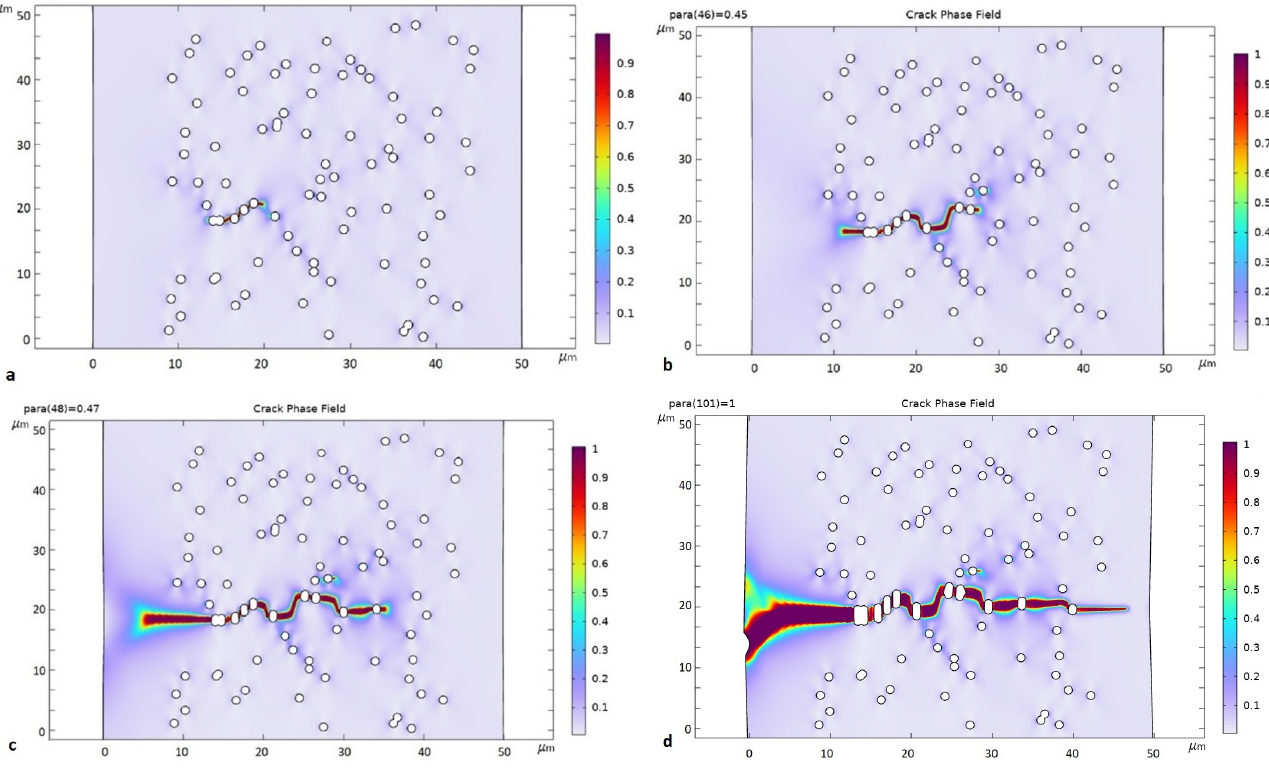
Figure 10. Development of crack under one-axis elongation, where the direction of deformation is vertical: ( a ) ε = 1.7%; ( b ) ε = 1.8%; ( c ) ε = 1.9%; ( d ) ε = 4%. Values of ϕ from ~0.9 to 1 (color scale) characterize a destroyed material.